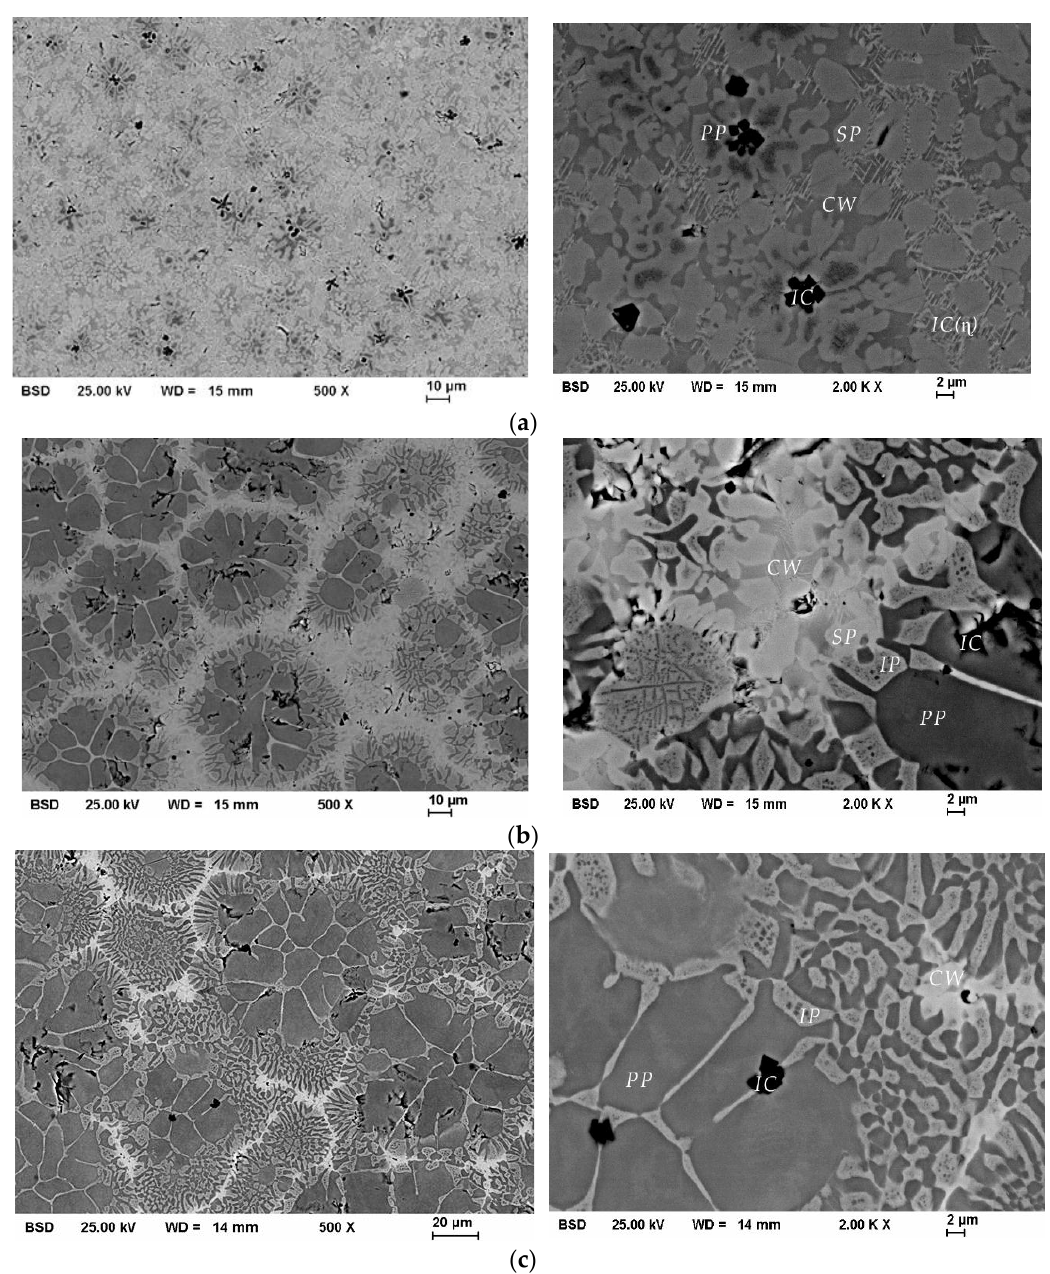
Figure 2. BSD images of the cast Al x CoCrFeNiTi alloy with x = ( a ) 0.2, ( b ) 0.8, and ( c ) 1.5 in overall view ( left ) and in detail ( right ) with phase declaration (PP: primary phase; IP: interdendritic phase; SP: secondary phase; CW: cell wall; IC: intermetallic compound).